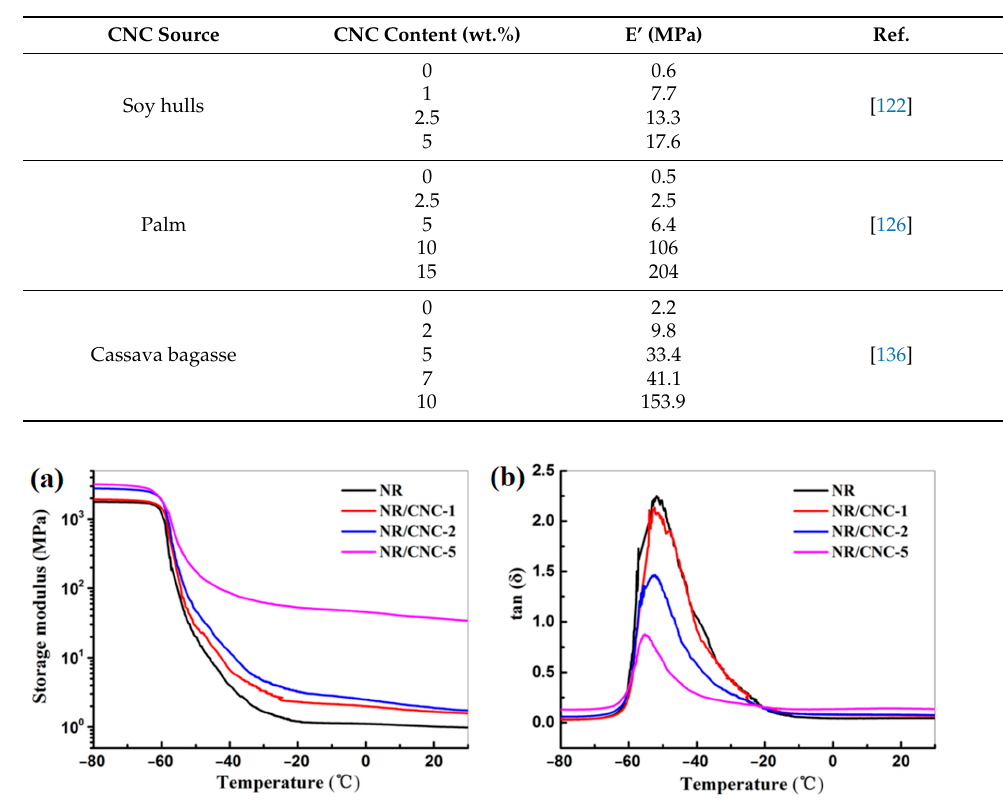
Table 6. Storage modulus (E’) at 25 ◦ C of NR nanocomposites with different nanocellulose contents.